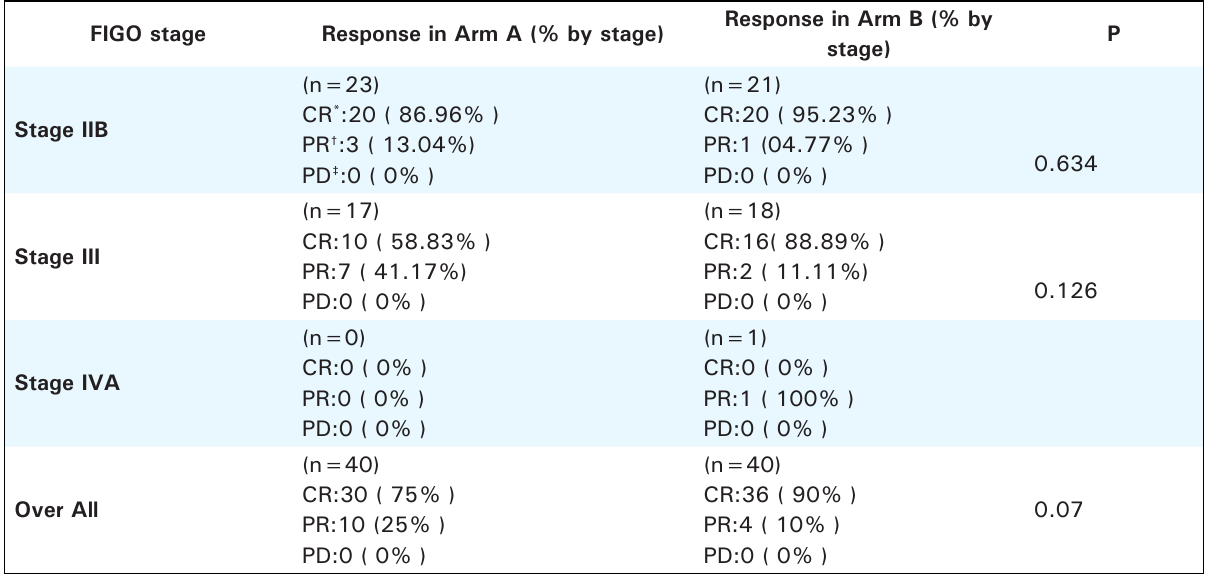
Table 2. Treatment response after 6 months following completion of treatment according to FIGO stage.